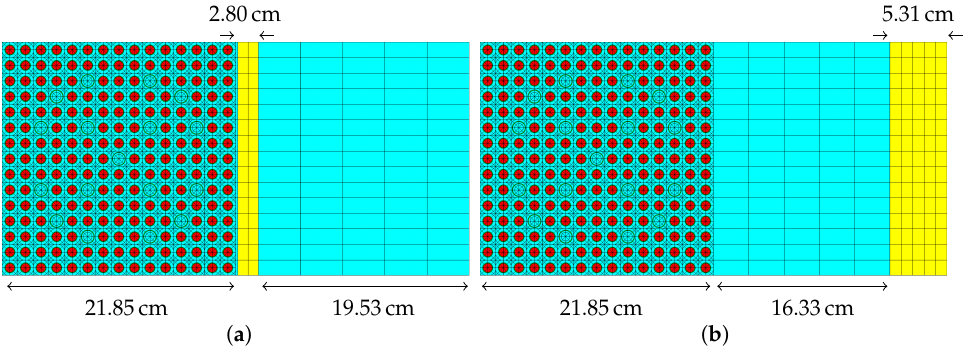
Figure 12. Reflector configurations in Polaris, ( a ) radial reflector, ( b ) axial